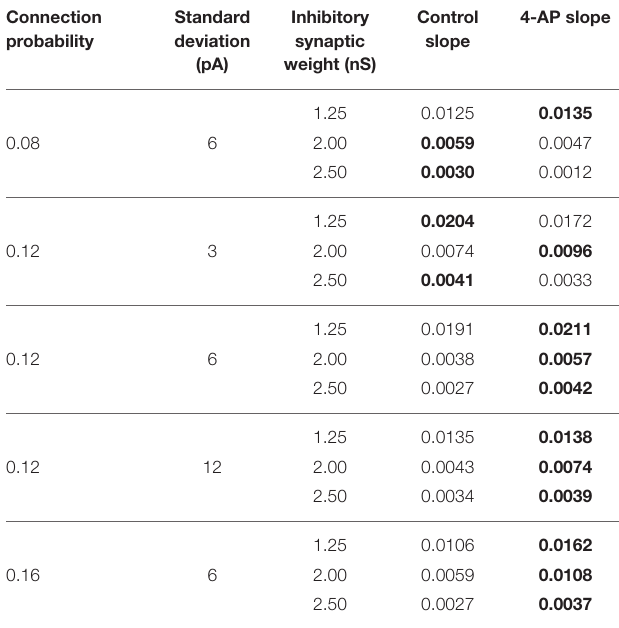
TABLE 2 | Slopes quantifying “sharpness” of the transition from asynchrony to synchrony seen in Figures 8 , 9 . Connection